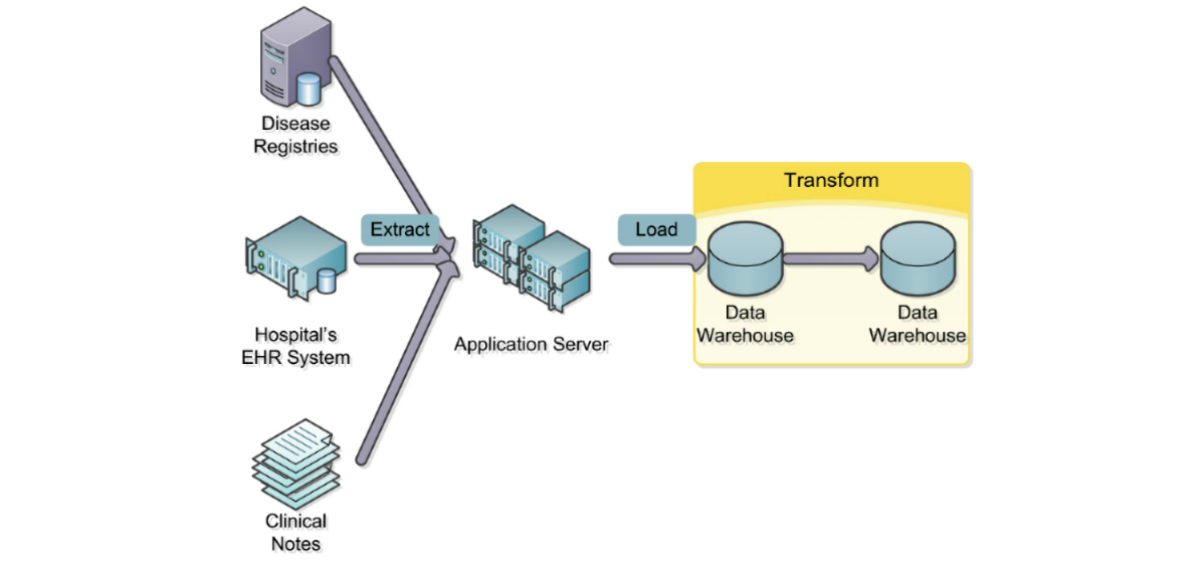
Figure 3. An example of the transformation stage in the extract, load, and transform (ELT) process (for a higher resolution image, see Multimedia Appendix 1). The SNOMED CT annotation "Deep venous thrombosis" made originally in the EHR, is mapped in the UMLS to the "Deep